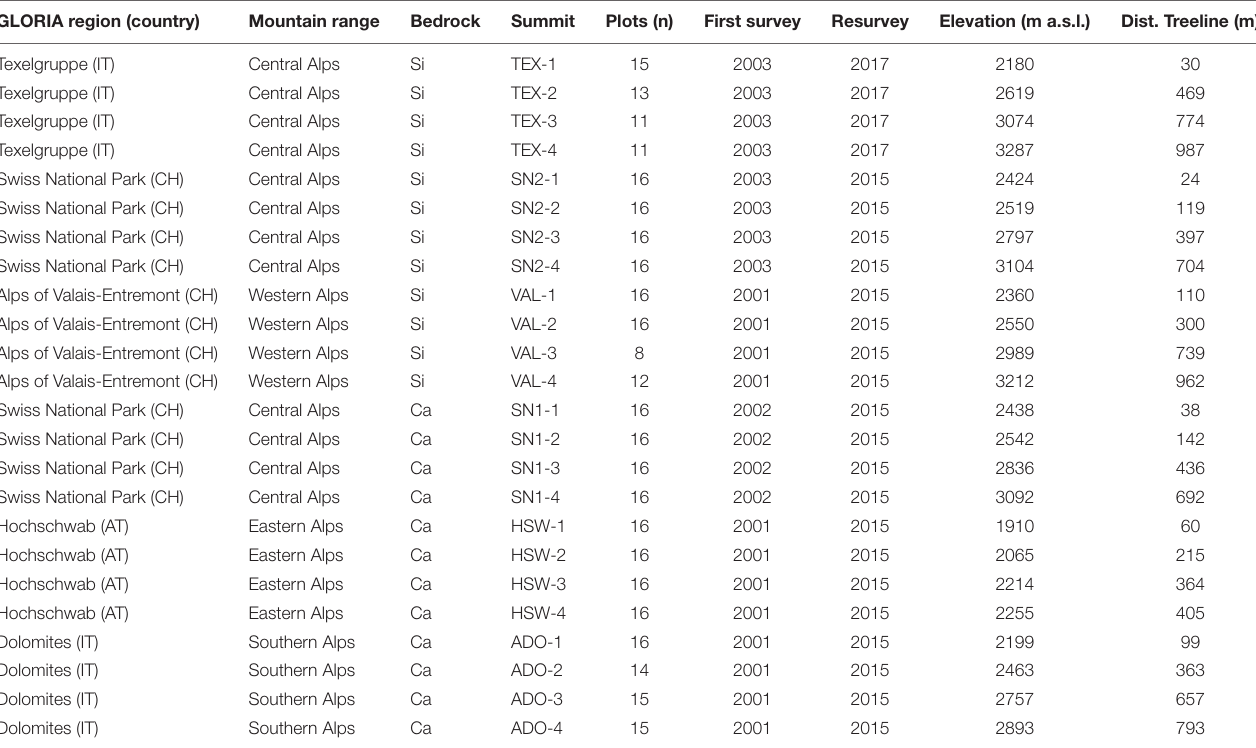
TABLE 1 | Geographical distribution (GLORIA region, country: AT = Austria, CH = Switzerland, IT = Italy; mountain range), bedrock (Si = siliceous, Ca = calcareous), summit designation (combined of the region’s three-digit code and the summit number in ascending elevation), number of 1 m × 1 m permanent plots, year of first survey/resurvey, elevation (in m), and relative position to the treeline of the 24 inventoried summits (Dist. treeline = elevation above the treeline, in